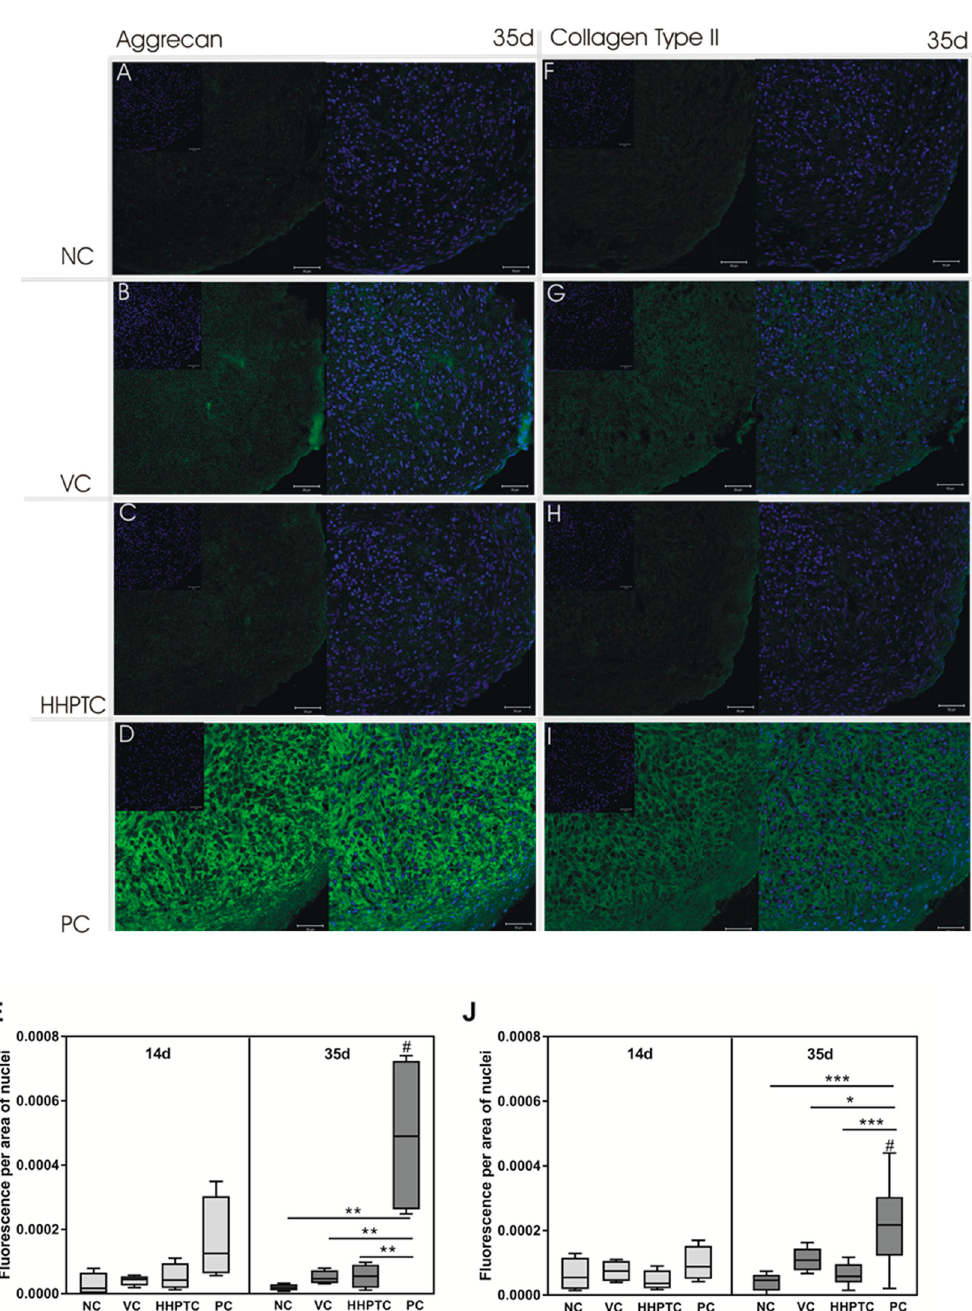
Figure 9. Aggrecan and collagen type II protein expression. Immunohistochemical staining of chondrocytic spheroid cultures at days 14 and 35 was performed using anti-human aggrecan and anti-chicken collagen type II antibody (green fluorescence). Nuclei were stained with Hoechst (blue fluorescence). Chondrocytic spheroids were cultivated in following media groups: Negative control (NC) ( A , F ), vital cartilage conditioned medium (VC) ( B , G ), high hydrostatic pressure treated cartilage conditioned medium (HHPTC) ( C , H ) and positive control (PC) ( D , I ). Exemplary images from day 35 depict aggrecan ( A – D ) and collagen type II ( F – I ) staining. Magnification: 200 × , scale bar: 50 µ m. For semi-quantitative analysis ( E , J ), the relative fluorescence signal was determined with ImageJ. After background correction, mean fluorescence signal was related to area of nuclei ( n = 8). Data are presented as boxplots with minimum, 25th percentile, median, 75th percentile and maximum. Statistical analysis was performed using Repeated Measures Two-way ANOVA with Bonferroni’s multiple comparison as post hoc test. Significance: * p < 0.05, ** p < 0.01, *** p < 0.001 between treatments and # p < 0.05 comparison between day 14 and